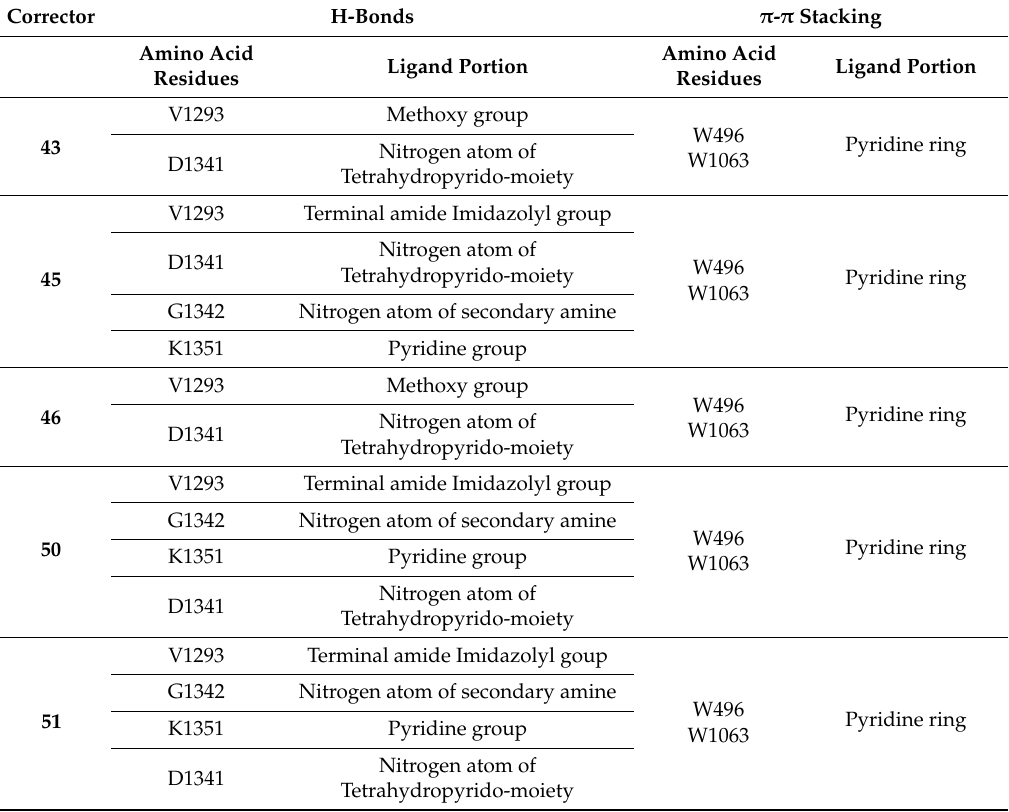
Table 3. Pattern of the most important interactions observed within the tetrahydropyridopyrimidines series at the modelled F508del-CFTR protein.